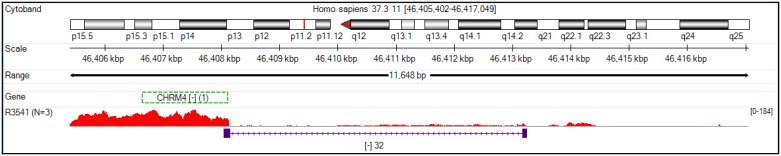
Junction reads through the M4L transcript from a human prefrontal cortex sample using OmicSoft Array suite.